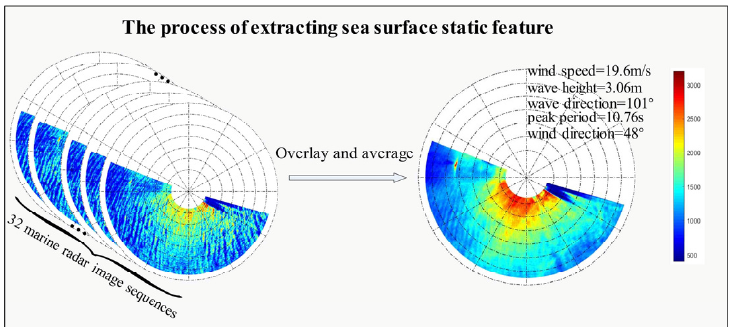
Figure 4. Process of overlaying and averaging 32 radar image sequences collected on 00:20 UTC+8 27 October 2010, obtaining a sea surface static feature image (including sea surface wind field information). The wind speed during measurement was 19.6 m/s, the wave height was 3.06 m, the wave direction was 101°, the peak period was 10.76 s, and the wind direction was 48°.